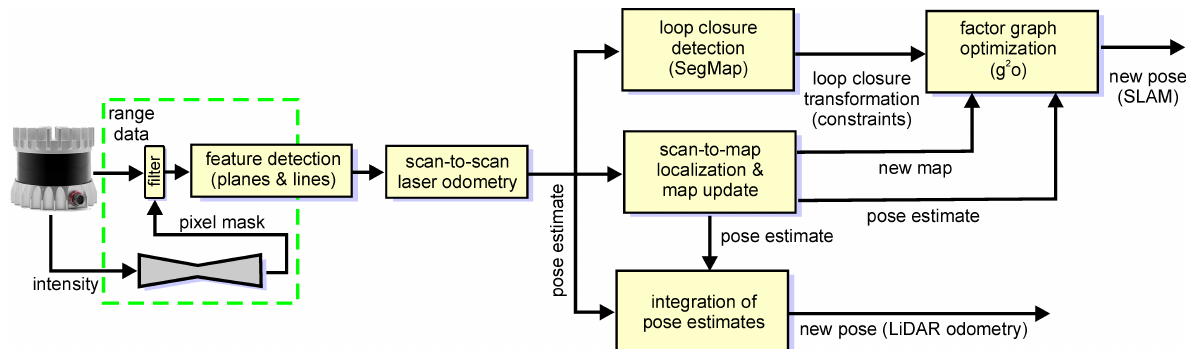
Figure 8. Block scheme of the modified PlaneLOAM architecture with an intensity-based neural filter (indicated by the green dashed line) that removes in real-time measurements originating from non-stationary